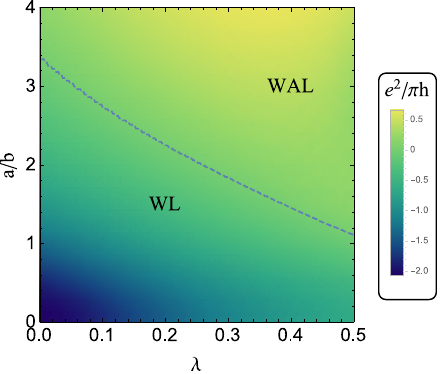
Figure 1. Phase diagram representing the evolution of the quantum correction to the conductivity σ qi ( 0 ) at zero magnetic field for massless and massive Dirac fermions. The parameters a , b and λ are defined in Section 2. The extrinsic spin-orbit scattering strength is quantified by λ , while the ratio a / b represents the ratio of the spin-orbit energy to the quasiparticle mass, evaluated at the Fermi energy. The conductivity is expressed in units of e 2 / h with the color bar on the right. The blue dashed line separates the WAL and WL regimes. The numerical parameters here are the same as those used in Figure 6